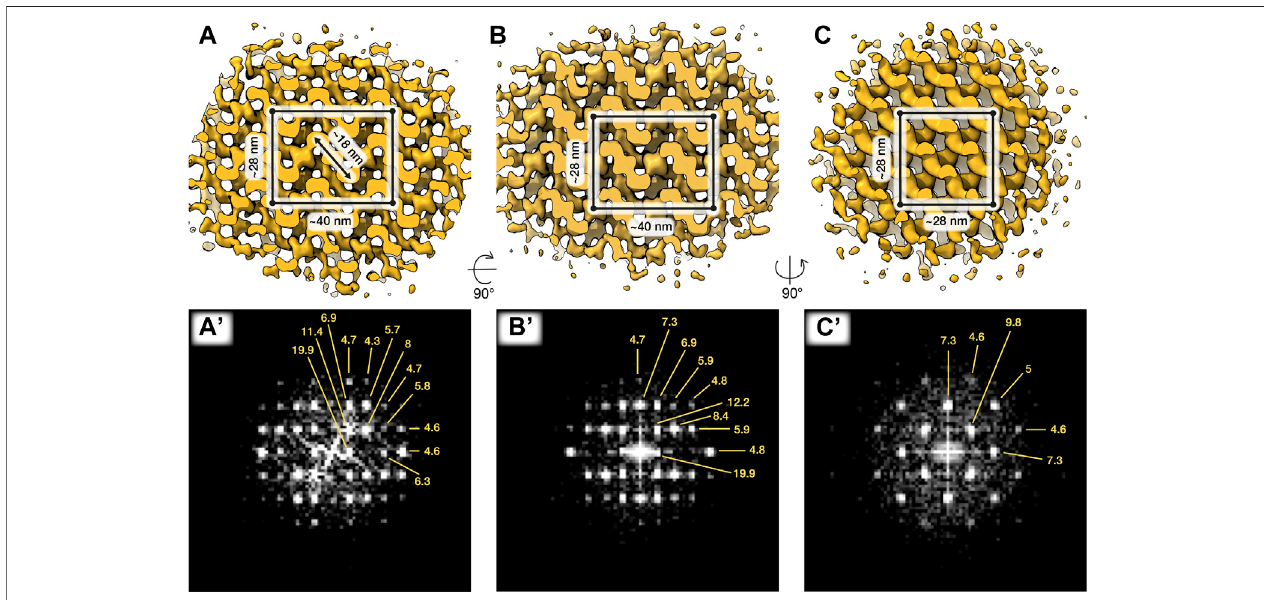
FIGURE 2 | In situ structures of paracrystalline patches from capacitated sperm. Three orthogonal isosurface views (A – C) and corresponding Fourier transforms (A ’– C ’ ) of a subtomogram average of (cid:1) 87 × 87 × 87 nm paracrystalline patch from swollen acrosomes of boar sperm incubated in capacitating media for ∼ 2 h. The putative tetragonal body-centered unit cell is annotated in (A – C) . Averages were generated from ∼ 1,400 particles from 2 cells.